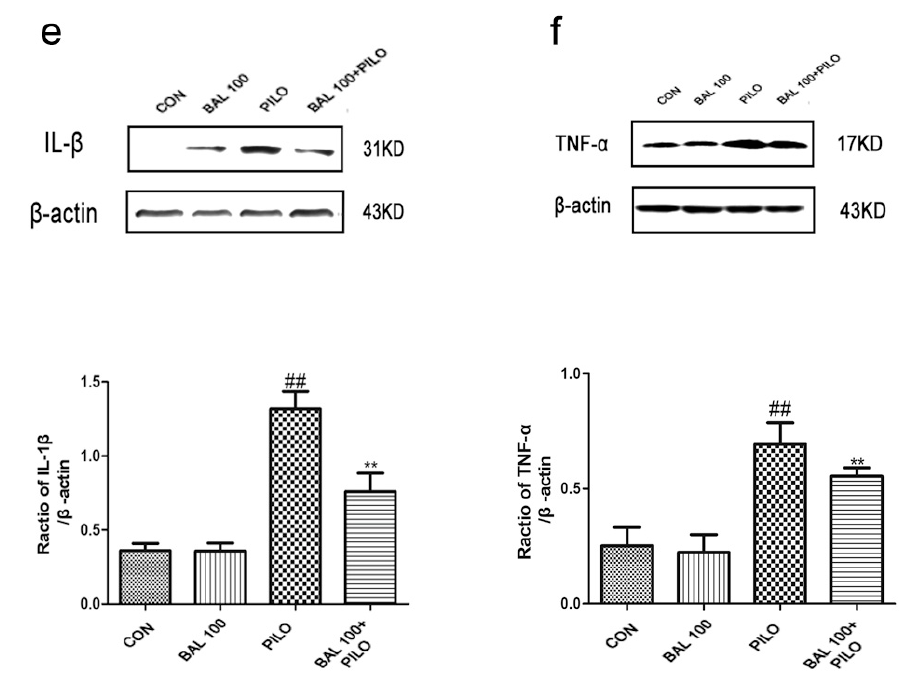
Figure 6. The expression of GABARa 1 ( a ), GABARb 1 ( b ), NMDAR 1 ( c ), d: BDNF ( d ), IL-1 β ( e ) and TNF- α ( f ) in brain tissue. Immunoblots showed target protein levels ( a – f ) 72 h after PILO-induced seizures. Data were expressed as mean ± SEM ( n = 6), ## p < 0.01 (Student-Newman-Keuls) compared to control group, ** p < 0.05 (Student-Newman-Keuls) compared to PILO group (One-way ANOVA and the Student-Newman-Keuls).